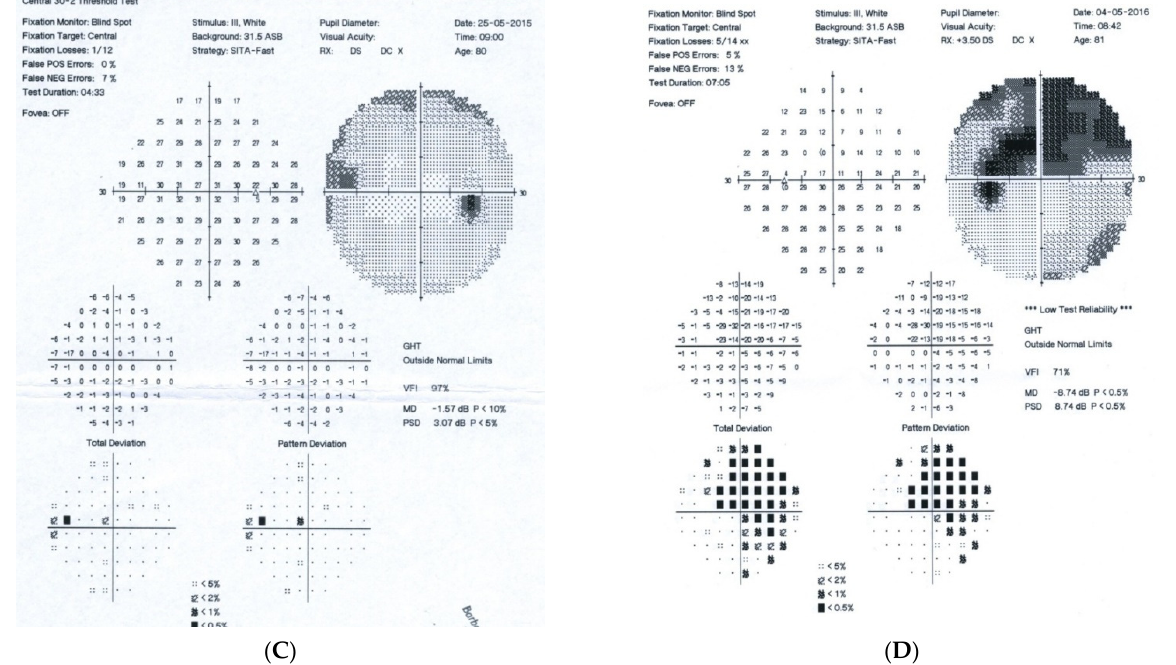
Figure 3. An 82-year-old male with pituitary gland adenoma. ( A ) Optic disc right eye. ( B ) Optic disc left eye. ( C ) Visual field right eye 05.2015 at initial visit. ( D ) Visual field left eye 05.2015 at initial visit.